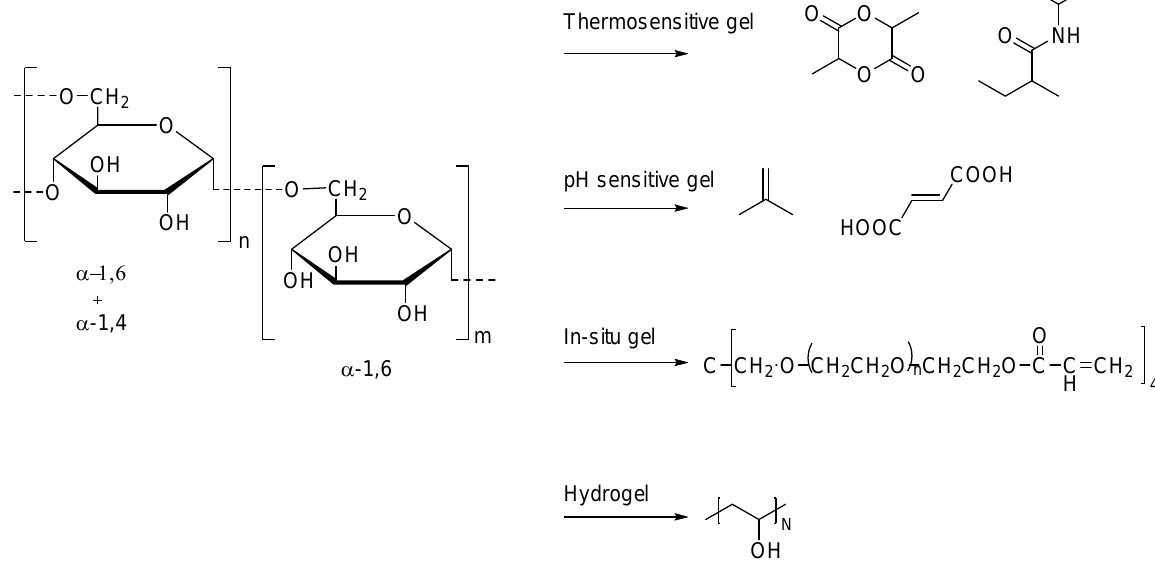
Figure 4. The structure of dextran and its modification in drug delivery.